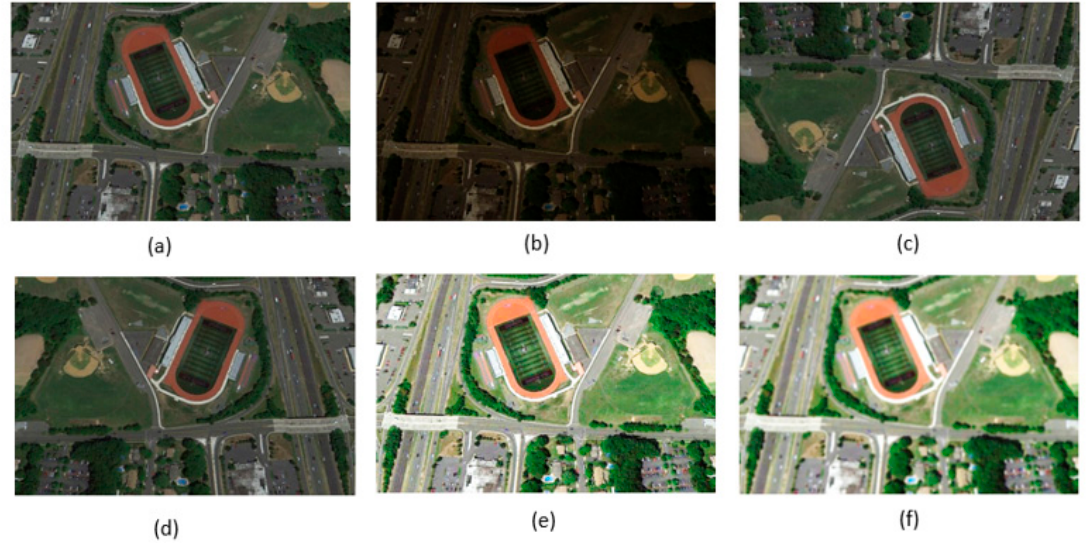
Figure 5. Data augmentation examples: ( a ) original picture; ( b ) blur; ( c ) vertical rotation; ( d ) horizontal rotation; ( e ) gamma conversion; ( f ) random image brightness.